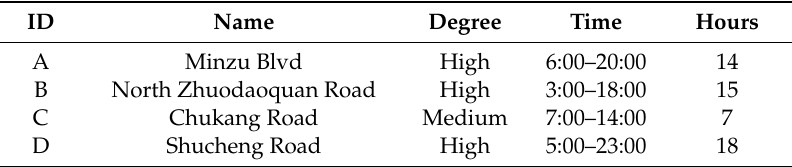
Figure 10. The time-series of representative roads. ( A )–( F ) are the time series of six representative roads that correspond to the symbols in Figure 9. The green lines and red lines indicate the average density of the sunny day and rainy day, respectively. Table 2. Flooding degree and time of representative flooded roads.